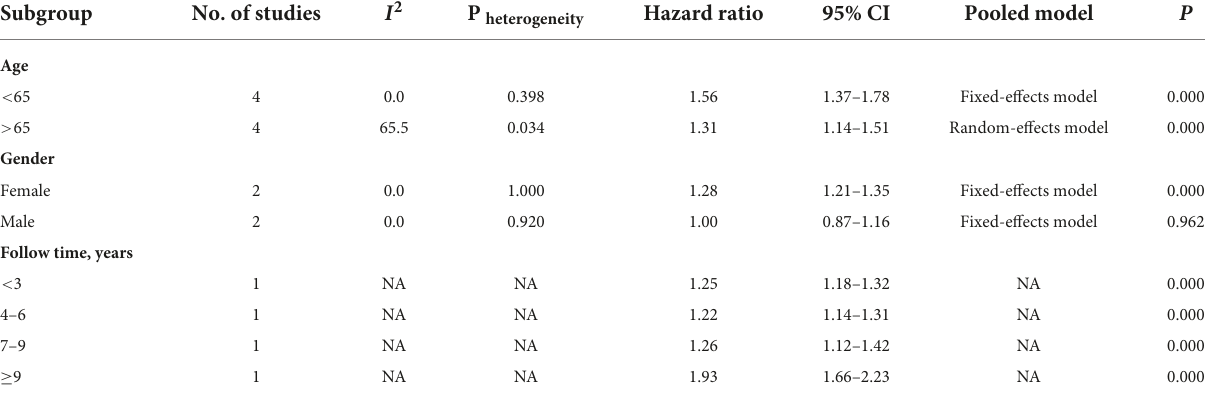
FIGURE5 Forest plot of the association between SS and risks of PD.